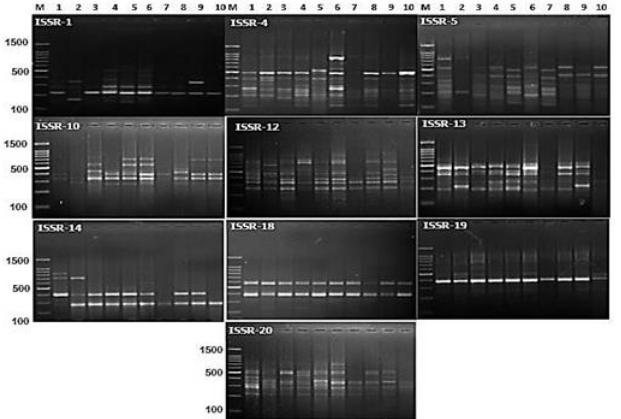
Figure 4. ISSR fingerprinting profile produced by the 10 primers in the examined populations of A. javanica .